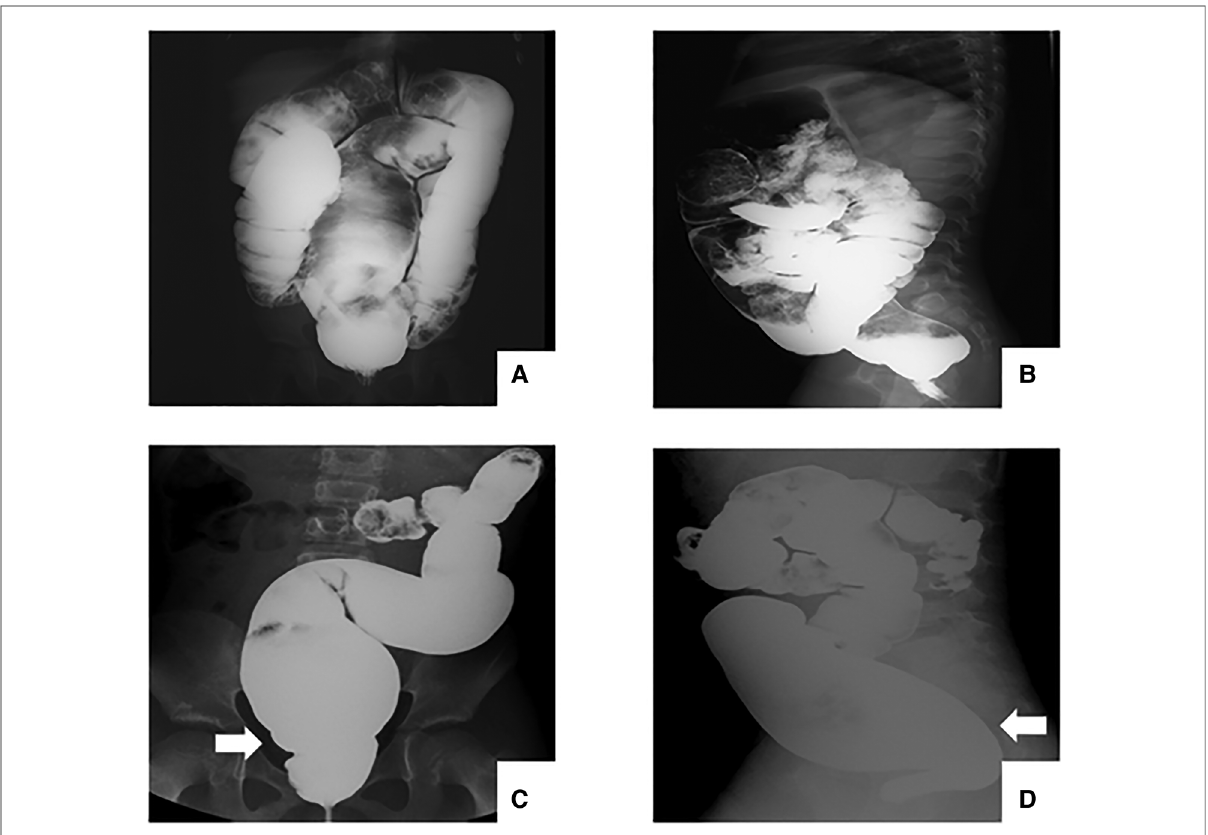
at diagnosis, 46 [38, 66] vs. 34 [6, 55] months, p = 0.002; age at surgery, 51 [39, 68] vs. 37 [10, 68] months, p = 0.001; weight at surgery, 15 [14, 18] vs. 12 [9, 17] Kg, p <